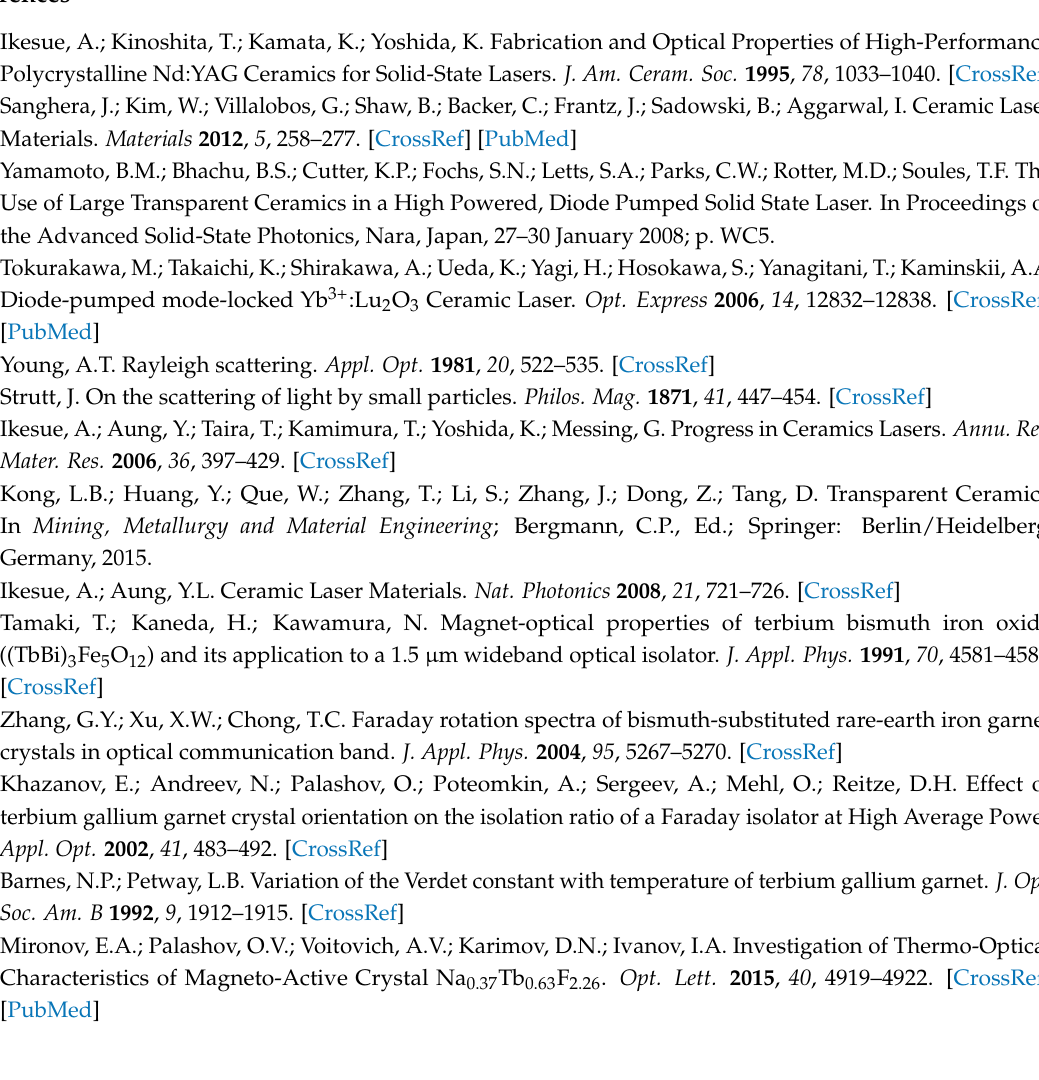
Figure S1:(a) External view, and (b) polarized optical microscopic image of (Tb 0.5 Y 0.5 ) 2 O 3 single crystal; Figure S2: Relationships between the Tb ion concentration and the refractive index, and the thermal conductivity; Figure S3: (a) Prototype of optical isolator using TYO (Tb-60%) ceramic in comparison with commercial TGG optical isolator. (b) Schematic diagram of optical isolator. (c) Magnetic flux distribution inside the magnet house of optical isolator and the position of Faraday rotator sample influenced by the magnetic field. (d) Comparison of features of each Faraday rotator material; Figure S4: Appearance of large scaled TYO ceramic samples with various aperture